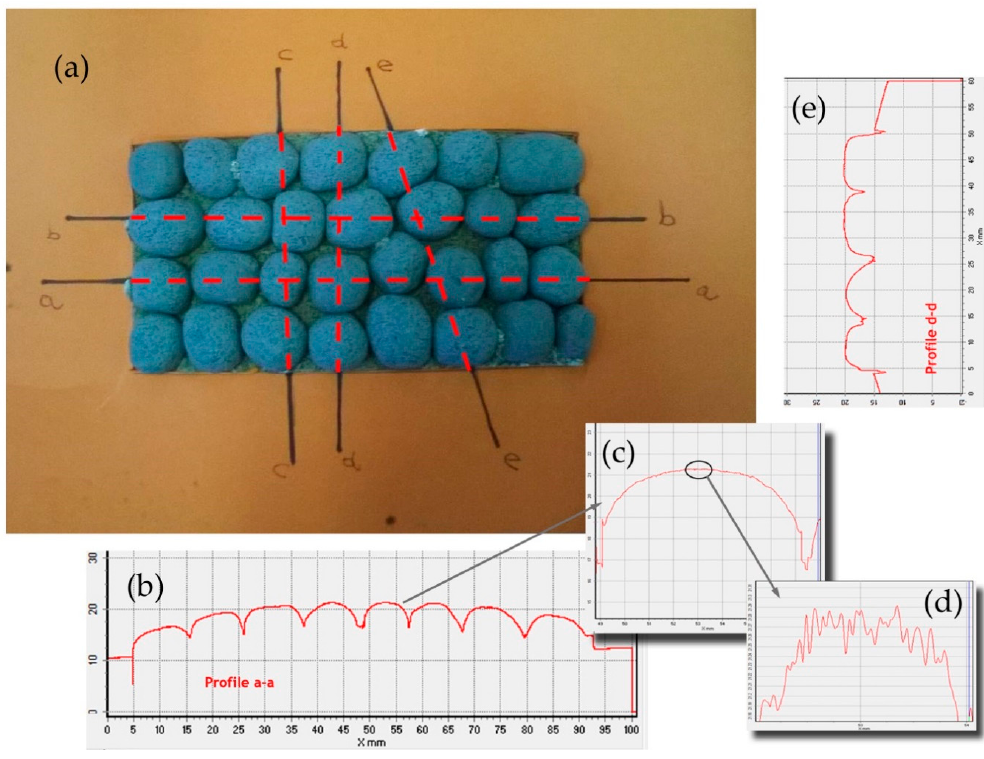
Figure 12. ( a ) Laser profilometer profile directions ( b ) profile along polishing direction a-a ( c ) zoom of granule surface ( d ) microprofile of granule surface ( e ) profile along crosswise direction d-d. Table 5. Roughness analysis by laser profiles post-processing: descriptions and formulas of roughness parameters derived from microprofiles.